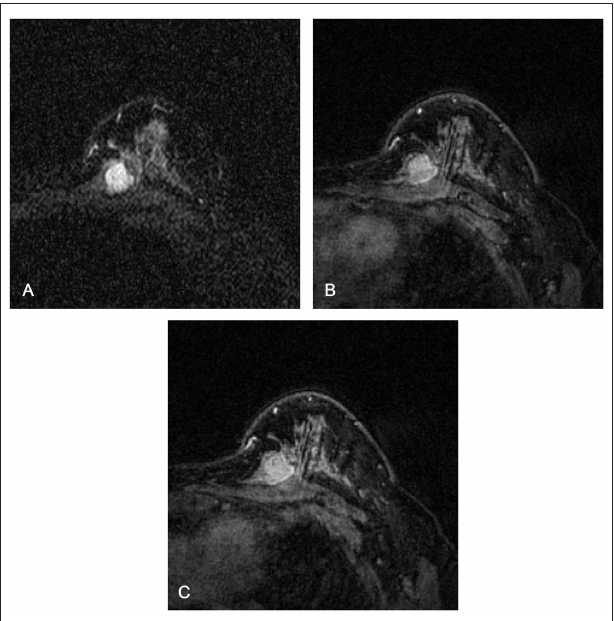
FIGURE 4 | Magnetic resonance images of a 37-year-old female patient with a borderline phyllodes tumor: (A) axial short TI inversion recovery T2-weighted (T2W-STIR) (B) first post-contrast (C) third post-contrast. The texture features on T2W-STIR correctly identified a phyllodes tumor which was falsely interpreted as a fibroadenoma on clinical and conventional MRI features, possibly owing to the weak lobulation, homogeneous signal on T2W-STIR, and absence of cystic component and